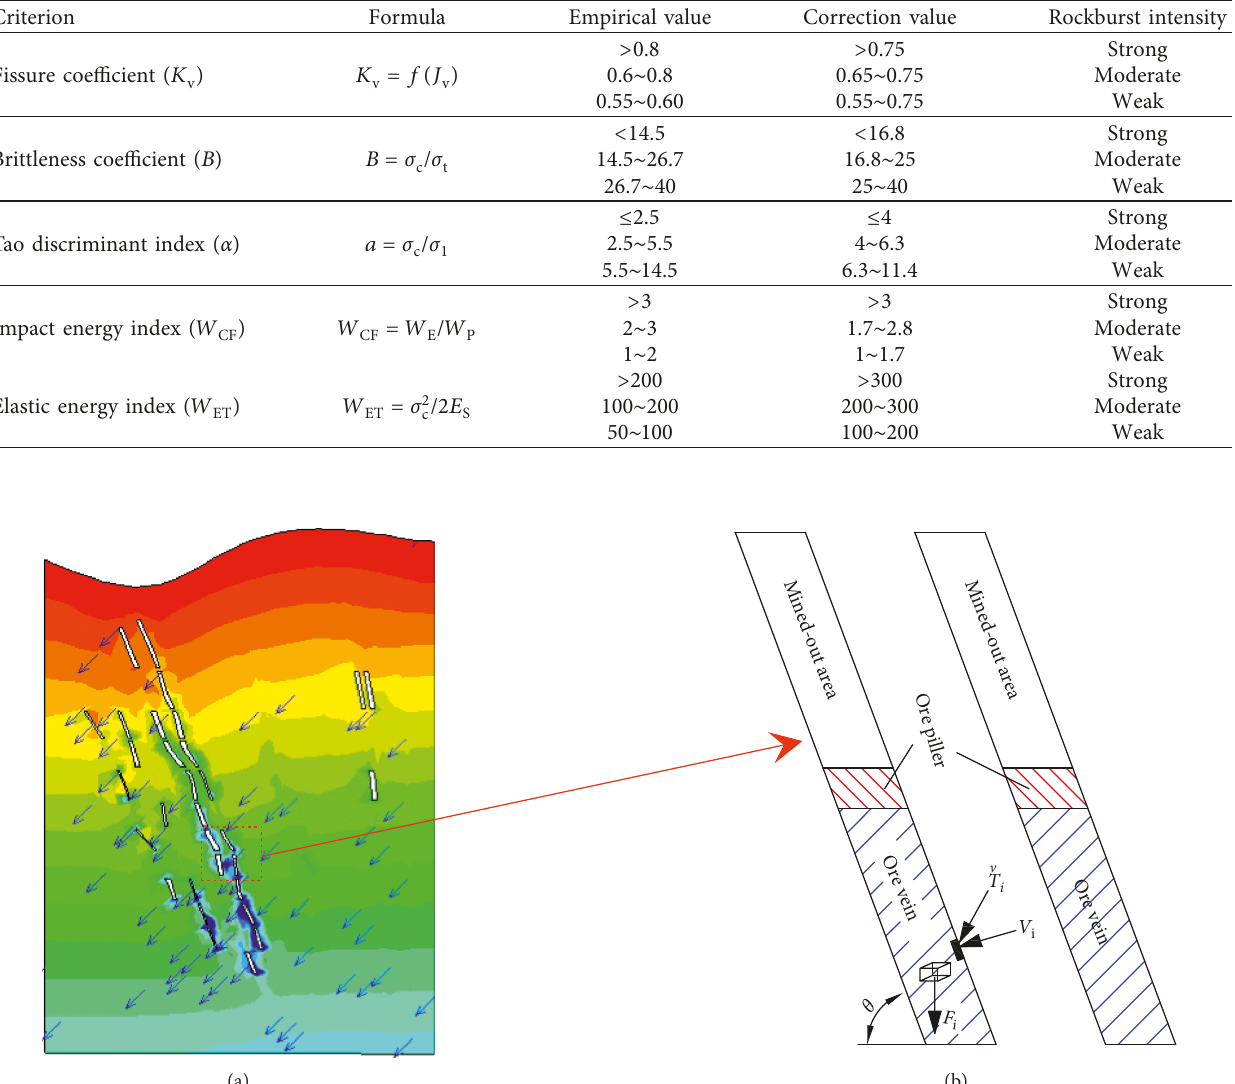
Table 3: Rockburst proneness criteria.